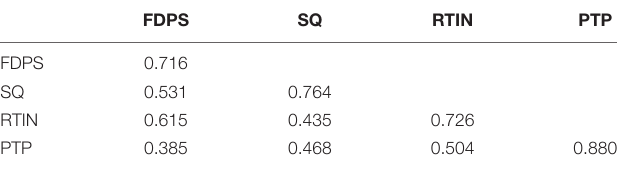
TABLE 2 | Discriminant validity.